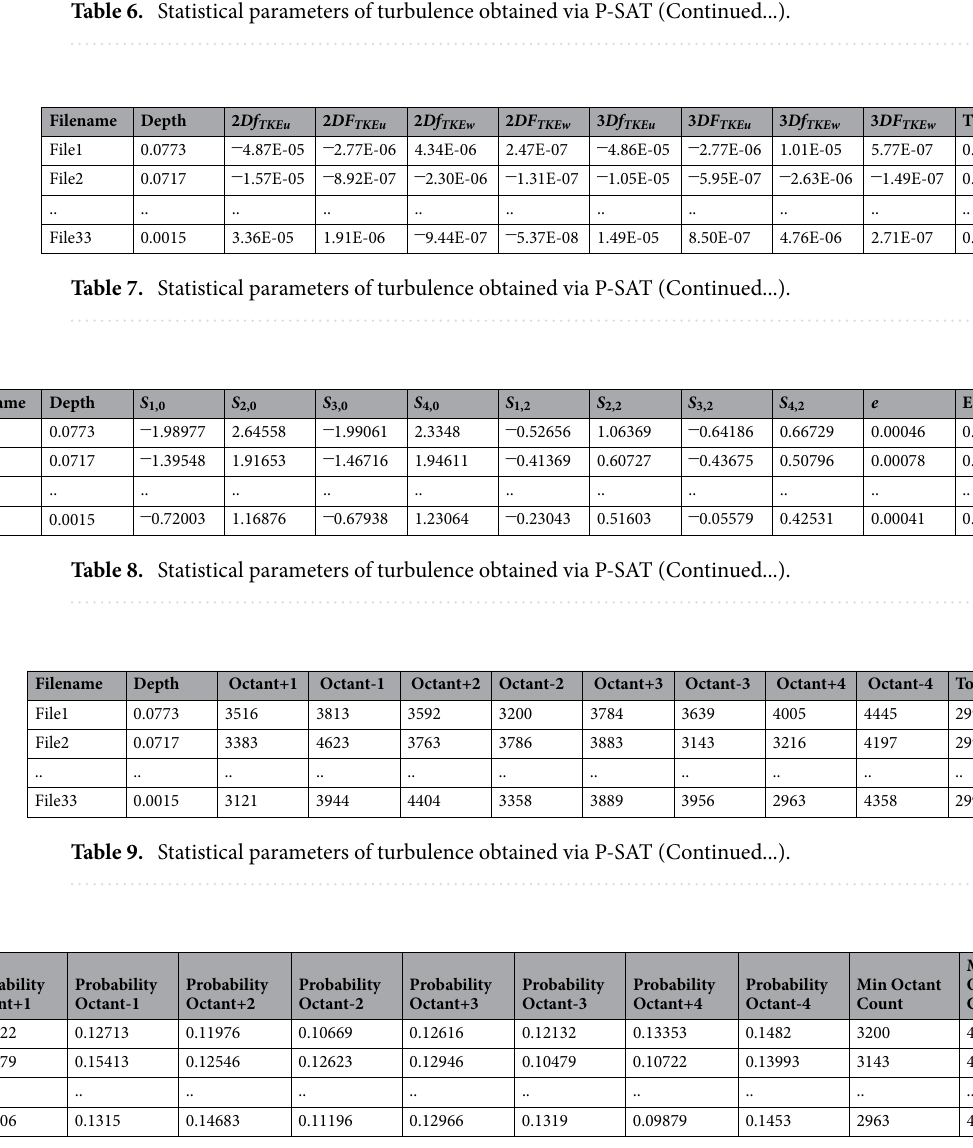
Table 10. Statistical parameters of turbulence obtained via P-SAT